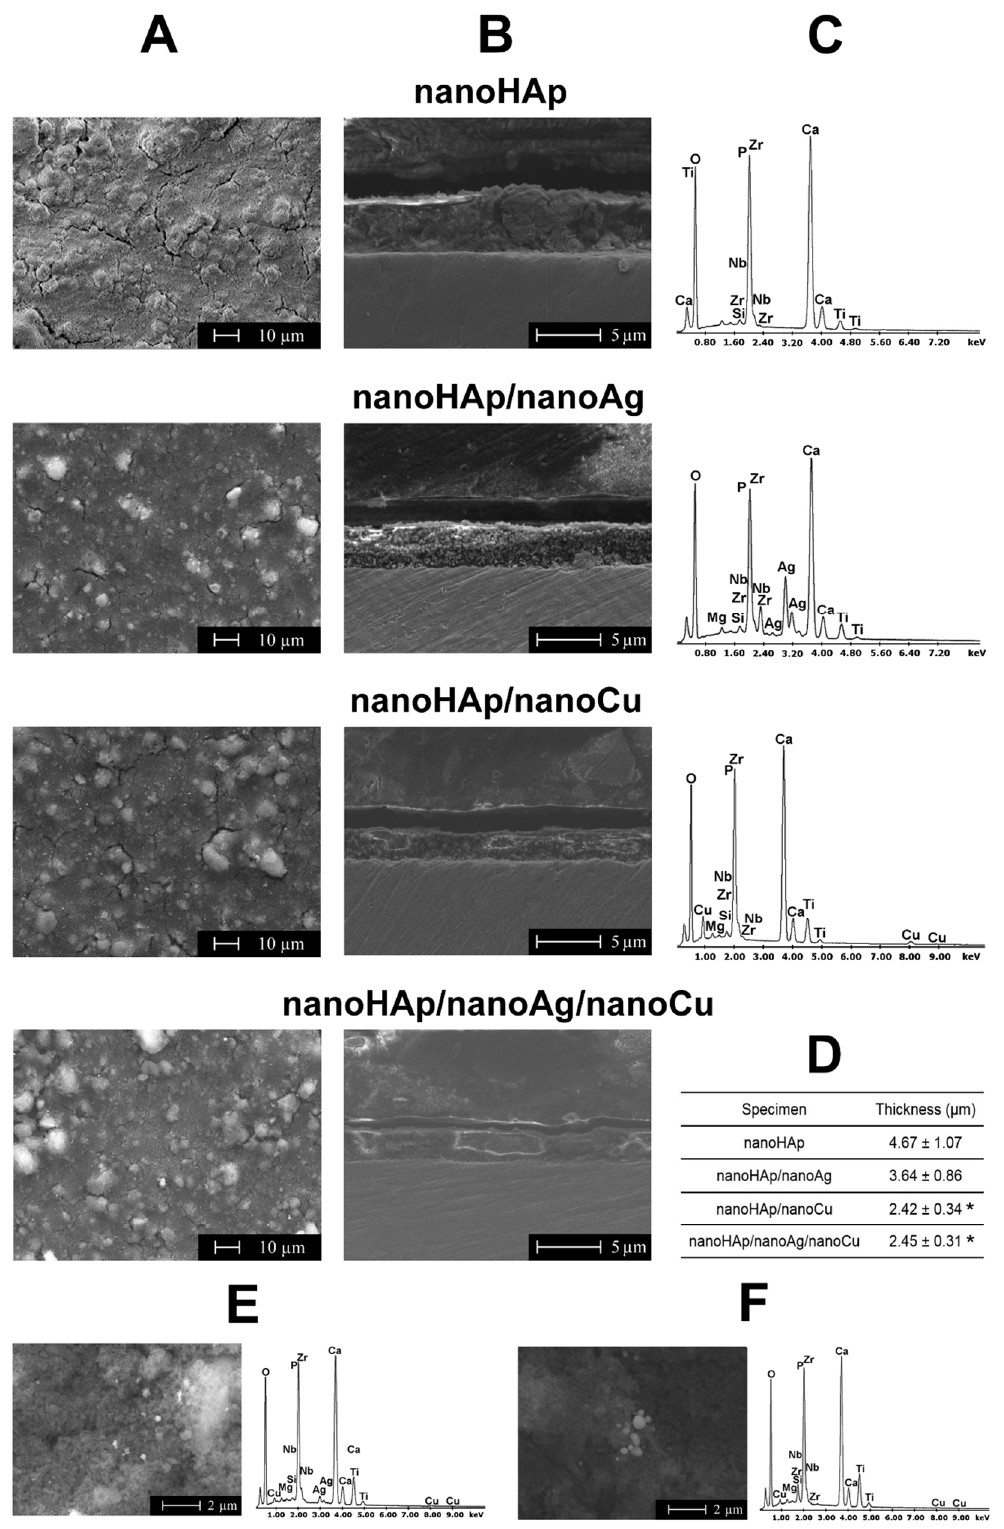
Figure 2. Scanning electron microscope (SEM) images of nanohydroxyapatite-based coatings. Coatings topography (( A ) column), the thickness of the coatings (SEM images—( B ) column, value—( D ) table), elemental contents ( C ), and SEM images with energy-dispersive X-ray spectroscopy (EDS) spectra from the selected area. SEM images of topography and EDS spectra of nanoHAp/nanoAg/nanoCu coatings before ( E ) and after ( F ) heat treatment. (* significantly different results compared to the nanoHAp coating, according to a one-way analysis of variance (ANOVA) test followed by Tukey’s multiple comparison test, p <0.05).